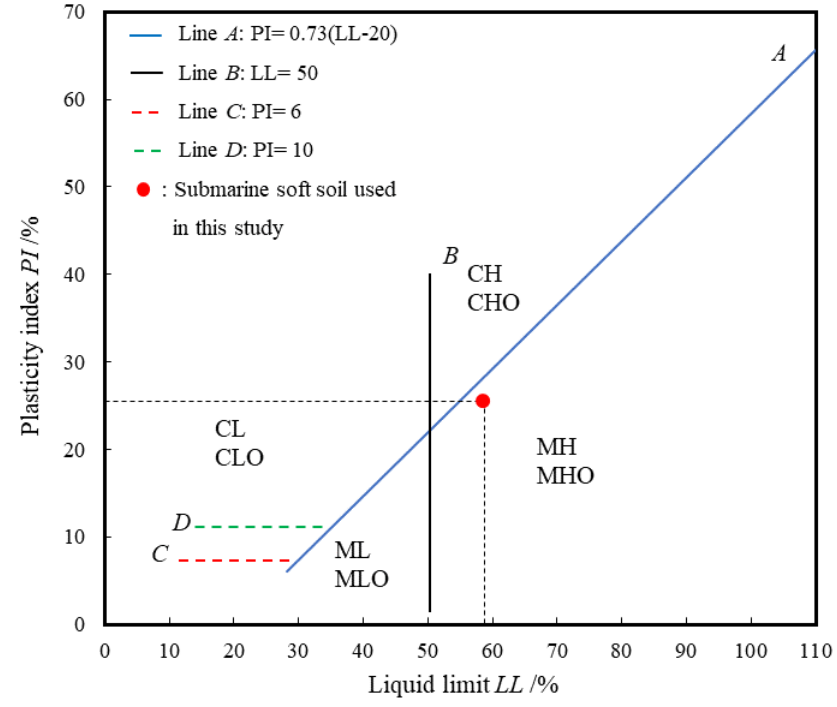
Figure 4. Plasticity diagram (ASTM D2487). Note: CL: Low-plasticity clay; CLO: Low-plasticity